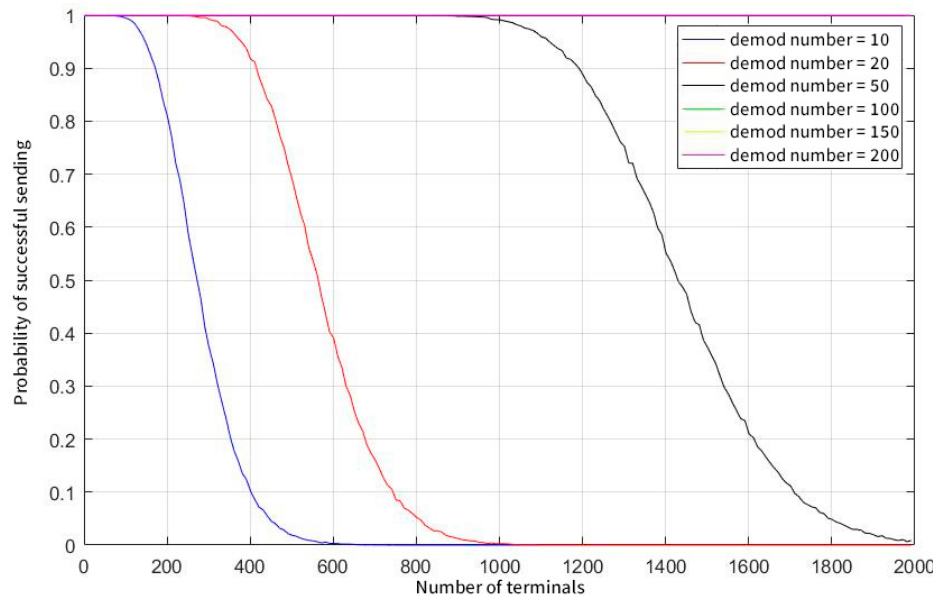
Figure 9. Probability of successful sending when sending interval of terminals equals 15.